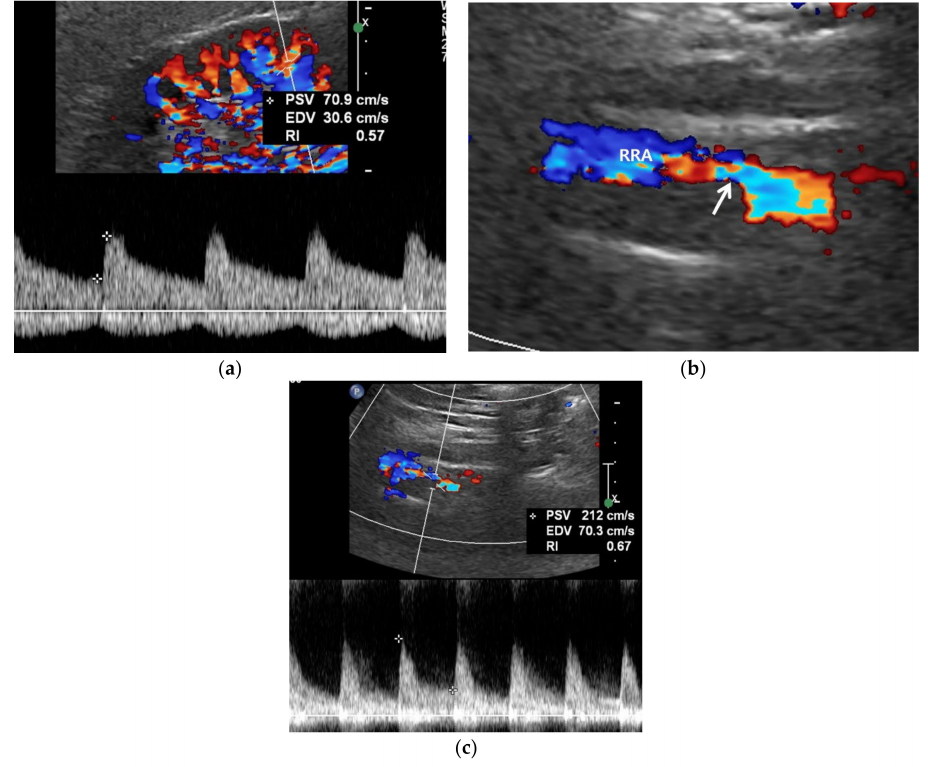
Figure 3. RAS-positive renal artery US in a 20-year-old man with negative renal US. ( a ) Spectral Doppler US does not show pulsus tardus and parvus pattern in the right kidney even though the size (11 cm) and echogenicity appear normal. ( b ) Color Doppler US shows a focal stenosis (arrow) in the proximal right renal artery (RRA), suggesting RAS. ( c ) Spectral Doppler US shows a high peak systolic velocity (PSV) (212 cm/s) in the stenotic right renal